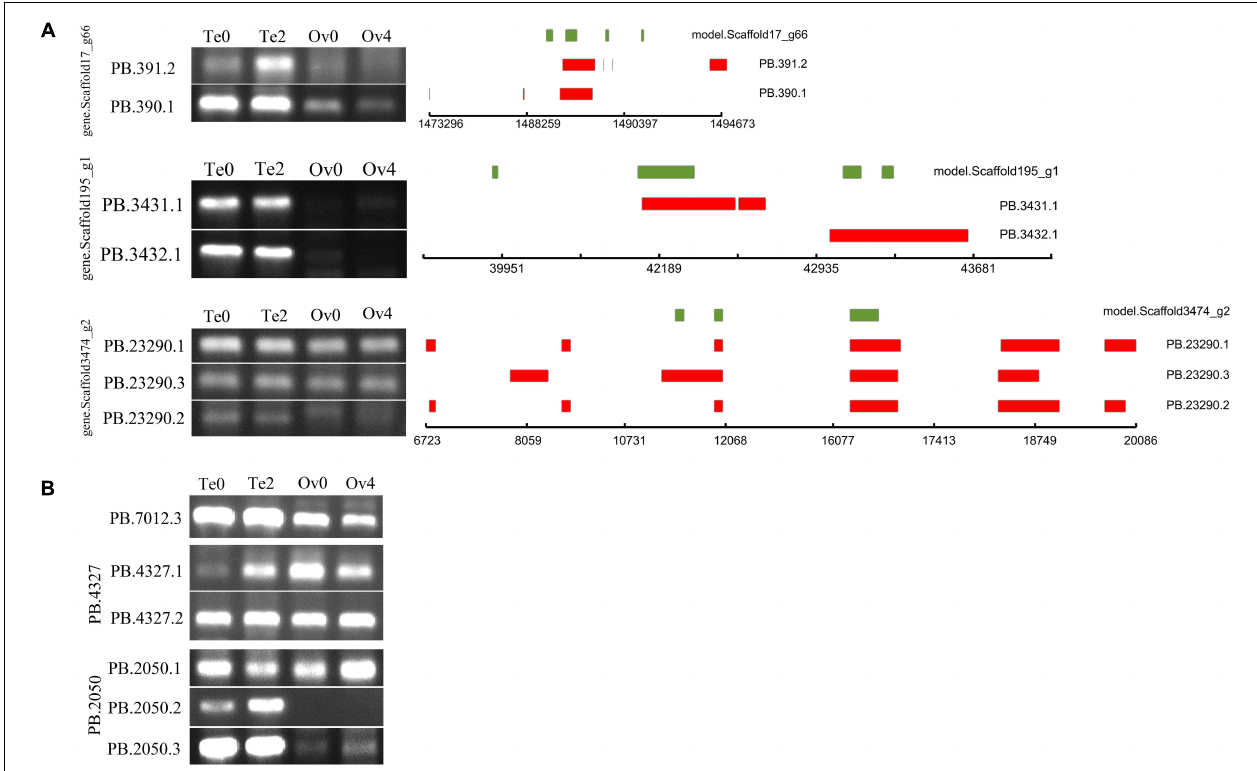
FIGURE 6 | PCR validation of AS events identified by Iso-Seq. The green box represents the gene model; the exons in transcripts are represented by red boxes. Gene ID is shown at the left for each panel. (A) AS events of annotated genes, (B) AS events of unannotated genes.